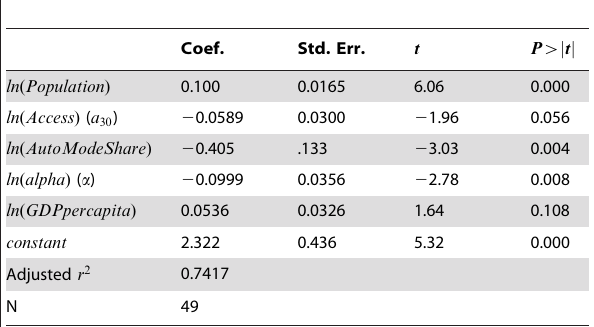
Table 5. Dependent Variable ln ( AutoModeShare ) .